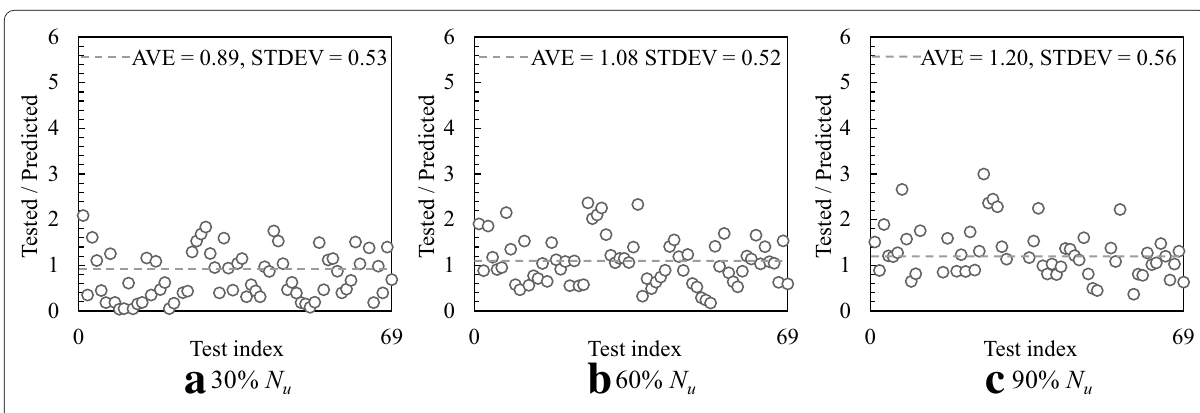
Fig. 21 Overall comparison between the tests and the proposed